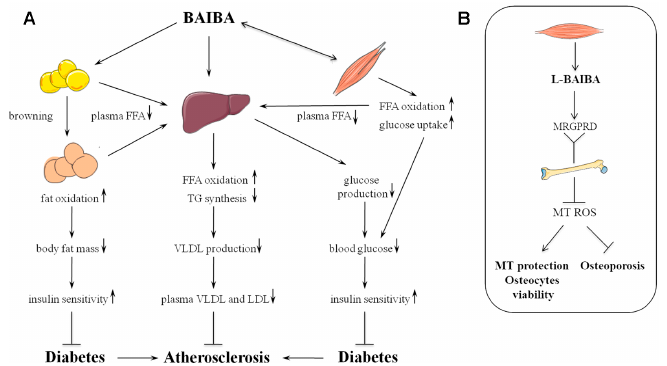
Figure 2. Proposed mechanisms of the biological effects of BAIBA. ( A ) Produced by skeletal myocytes and probably by other cell types, BAIBA regulates lipid and carbohydrate metabolism in fat tissue, liver, and skeletal muscles. BAIBA induces white to brown-like transformation of preadipocytes, which leads to an increase in fatty acids oxidation; it stimulates synthesis and/or activity of free fatty acids (FFA) oxidation enzymes in myocytes and hepatocytes as well. Together these processes lead to a lowering of plasma FFA level with subsequent decline in triglycerides (TG) synthesis and hepatic assembly of very low density lipoproteins (VLDL), the precursors of atherogenic low density lipoproteins (LDL) in the plasma. Decrease in body fat mass induced by adipose tissue “browning”, together with stimulation of skeletal muscles’ glucose uptake and down-regulation of hepatic glucose production enhance insulin sensitivity and reduce risk of diabetes and atherosclerosis. ( B ) L-BAIBA, but not its D-isoform binds to Mas-related G protein-coupled receptor type D (MRGPRD) on osteocytes. L-BAIBA diminishes reactive oxygen species (ROS) production in mitochondria (MT) and protects osteocytes from apoptosis, which results in prevention of bone loss [45].